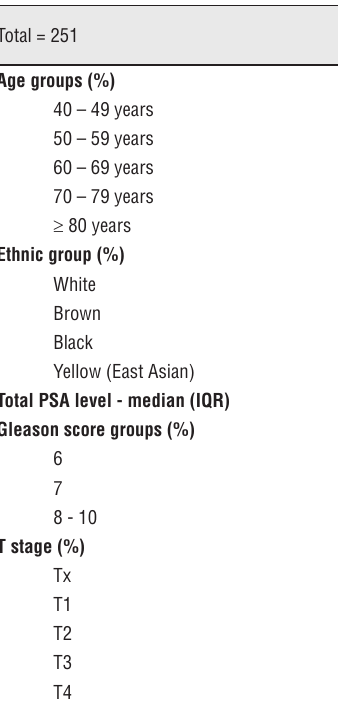
Table 2 - Distribution of the diagnosed men stratified according to the D’Amico risk